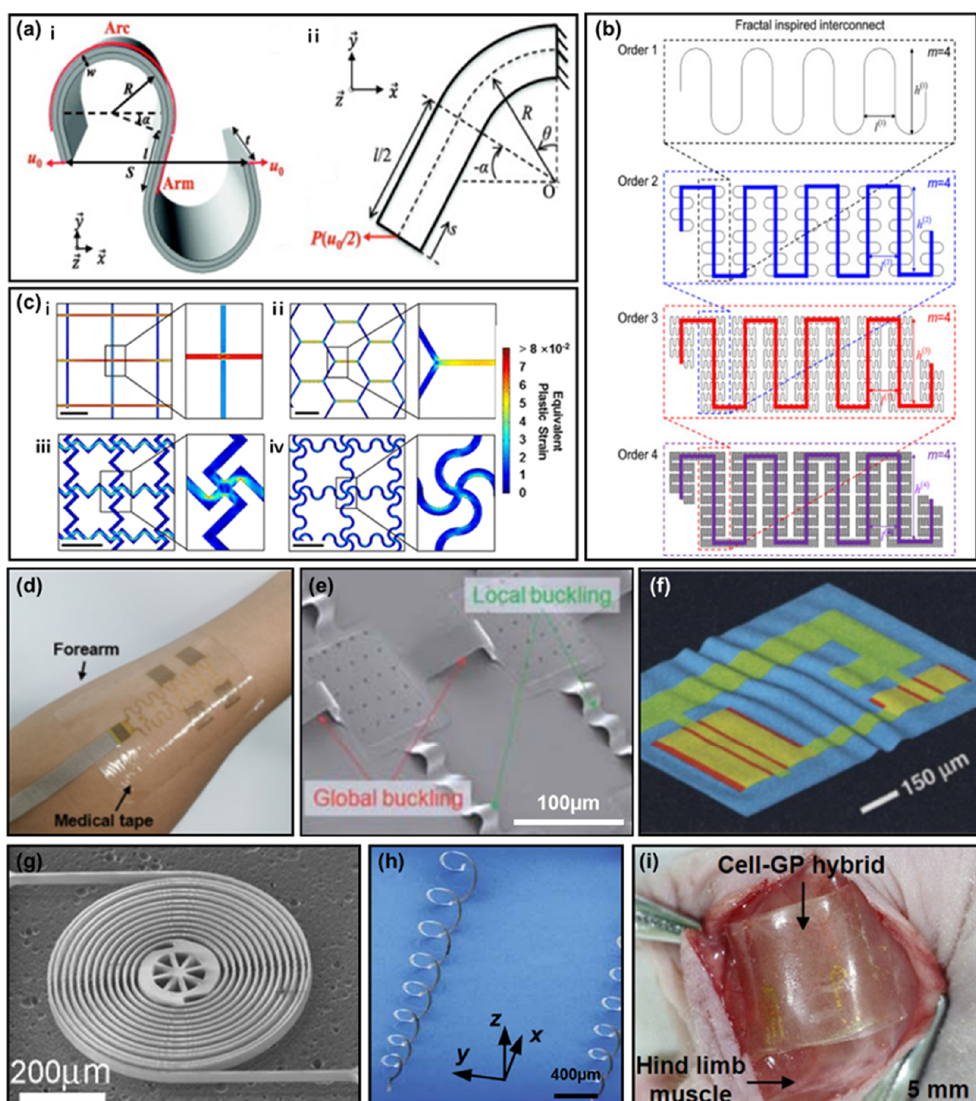
Figure 3. ( a – d ) Pattern designed interconnect: ( a ) serpentine pattern [94], ( b ) self–similar pattern [86], ( c ) mesh pattern [89], ( d ) equipment using serpentine pattern interconnect [96]; ( e – i ) 3D structural designed interconnect, ( e ) arc [109], ( f ) wave [13], ( g ) spiral [110], ( h ) helix structures [111], and ( i ) equipment using wave structure interconnect [112].